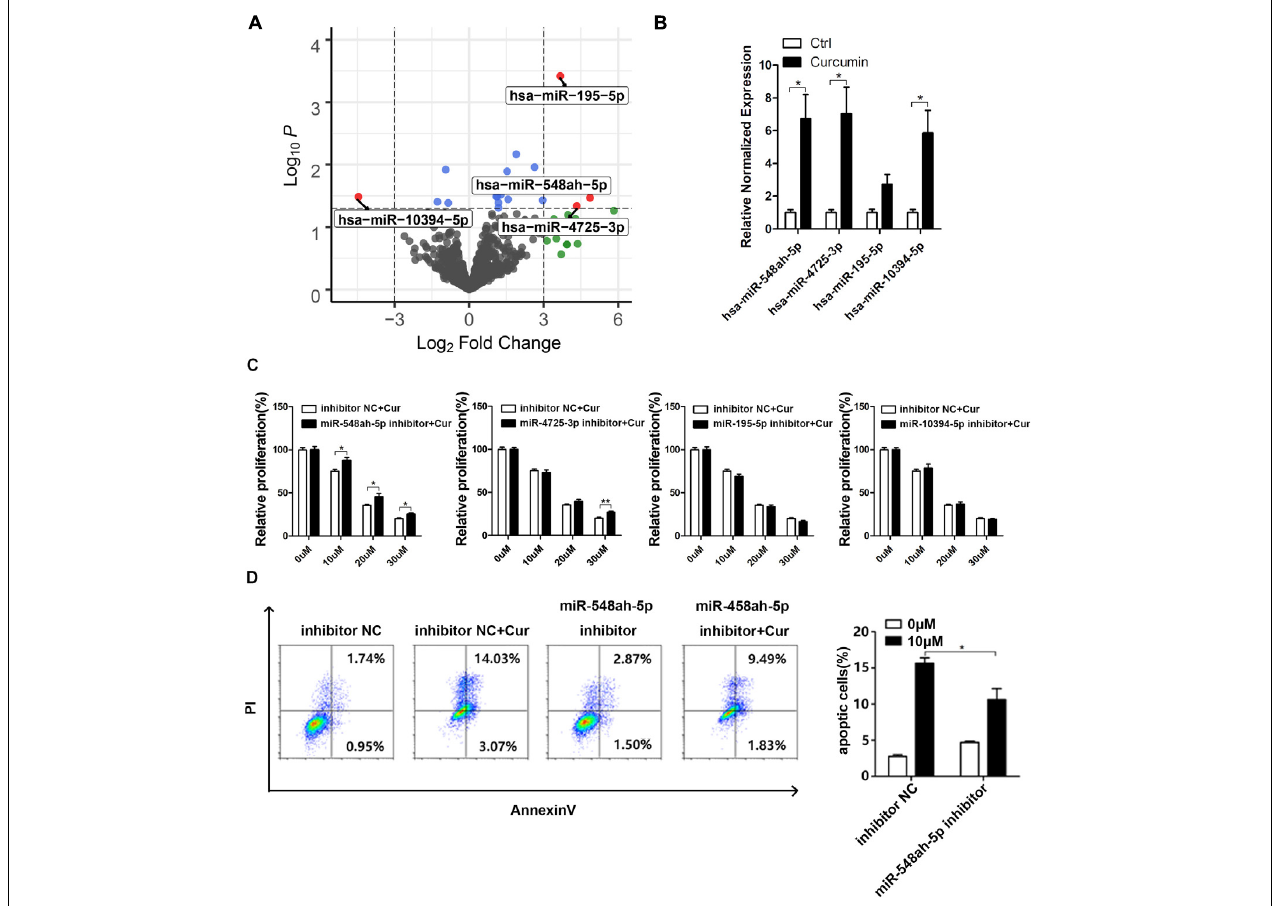
FIGURE 3 | MiR-548ah-5p regulated the curcumin-induced apoptosis of H446 cell line. (A) Volcano plot of all miRNA based on log2 fold change vs. the -log10 p -value. Each dot represented a miRNA, and significantly differentially expressed miRNAs were labeled as red. (B) Relative expression levels of miR-548ah-5p, miR-4725-3p, miR-195-5p, and miR-10394-5p were determined in H446 cells pre-treated with 10 µ M curcumin. (C) Relative viability of H446 cells pre-transfected with the inhibitor of miR-548ah-5p, miR-4725-3p, miR-195-5p, or miR-10394-5p was determined by CCK-8 assay after 24 h curcumin treatment (0, 10, 20, 30 µ M). (D) H446 cells transfected with the inhibitor of miR-548ah-5p were treated with curcumin (10 µ M) for 24 h and then the apoptotic cells were identified by Apoptosis Assays Kit. Quantification of apoptosis rate were shown. Data are showed as mean ± SEM ( n = 3); * P <